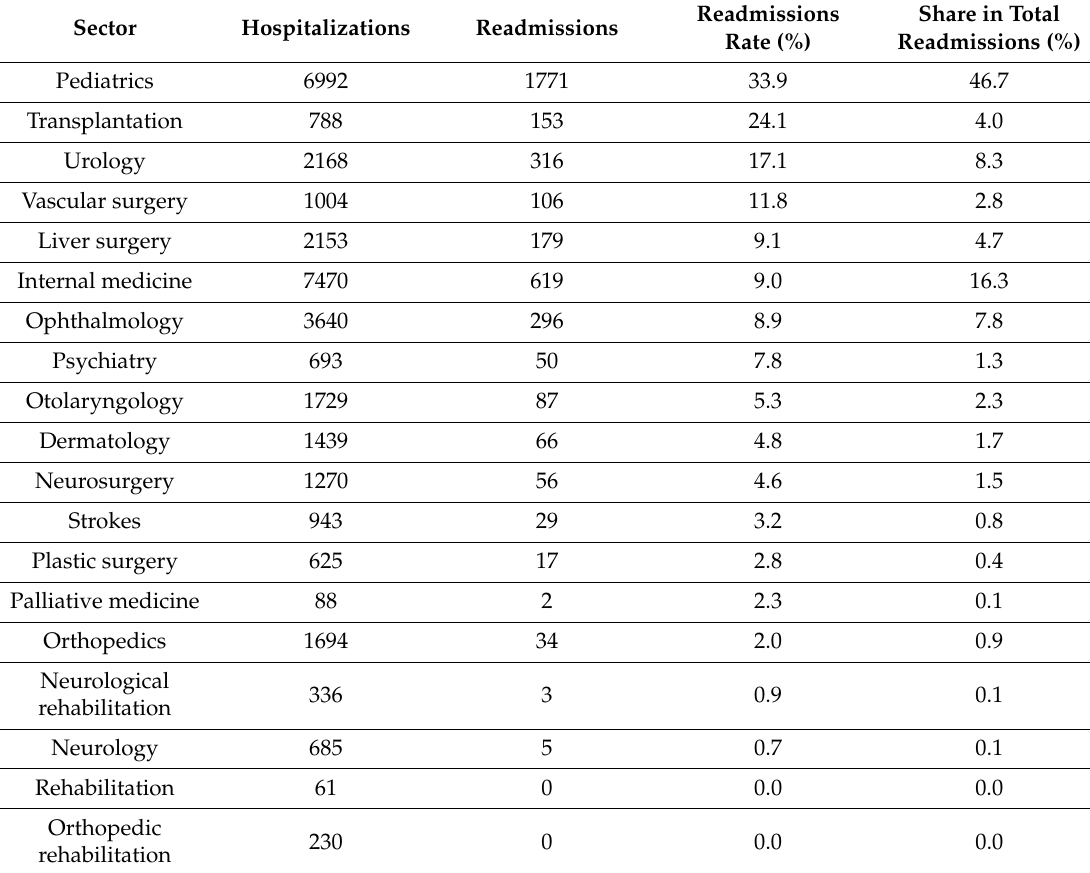
Table 2. Readmissions numbers and rates in hospital sectors.